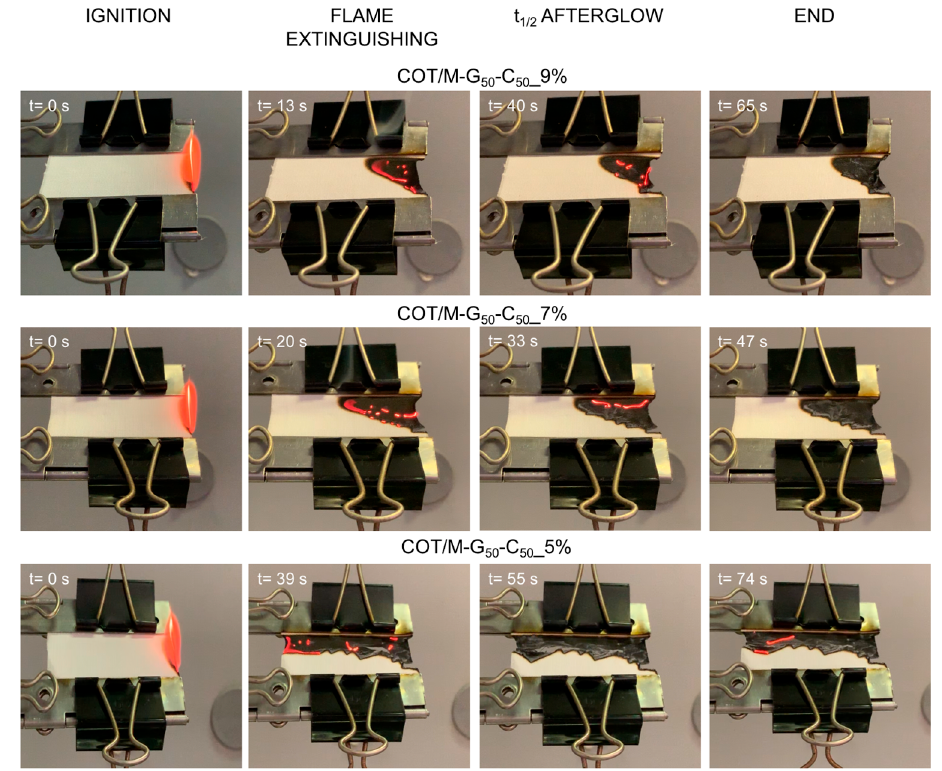
Figure 8. Snapshots of cotton fabrics treated with 9%, 7% and 5% add-ons of M–G 50 –C 50 copolymer in horizontal flame spread tests.